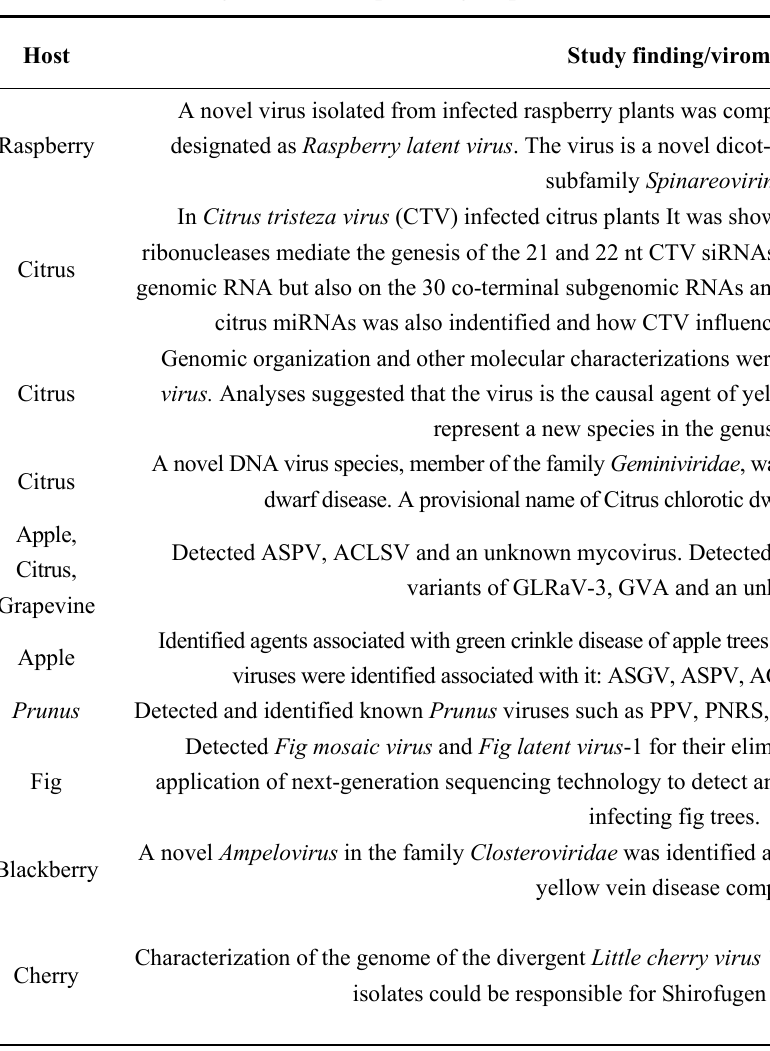
Sample Sequencing Ref. preparation/target platform dsRNA [55]